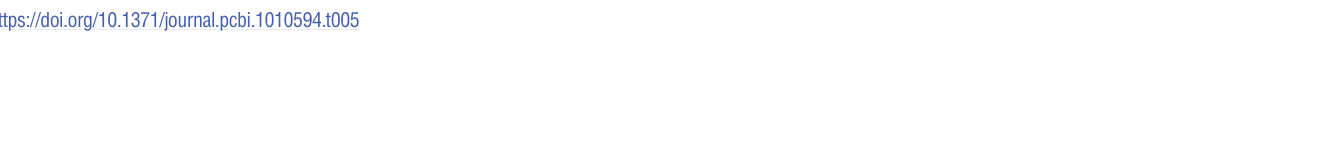
♠ Model hyperparameters and feature vector design can be found in S1 Table. If a dataset does not have neuronal region information, we constructed corresponding feature vectors from neuronal